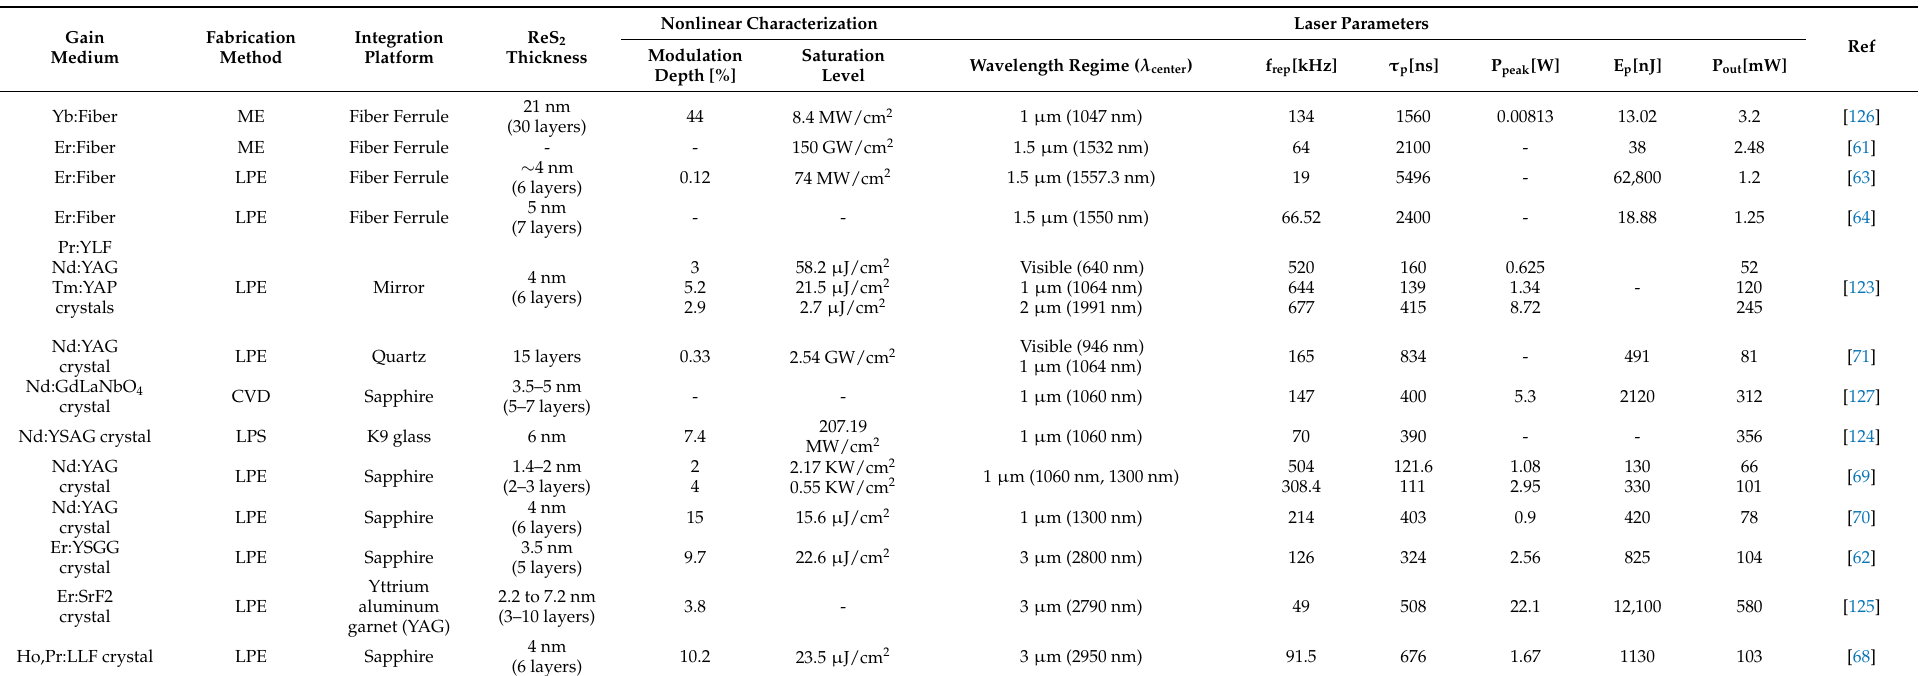
Table 2. Nonlinear optical characteristics and applications in laser cavities using ReS 2 for Q-switched